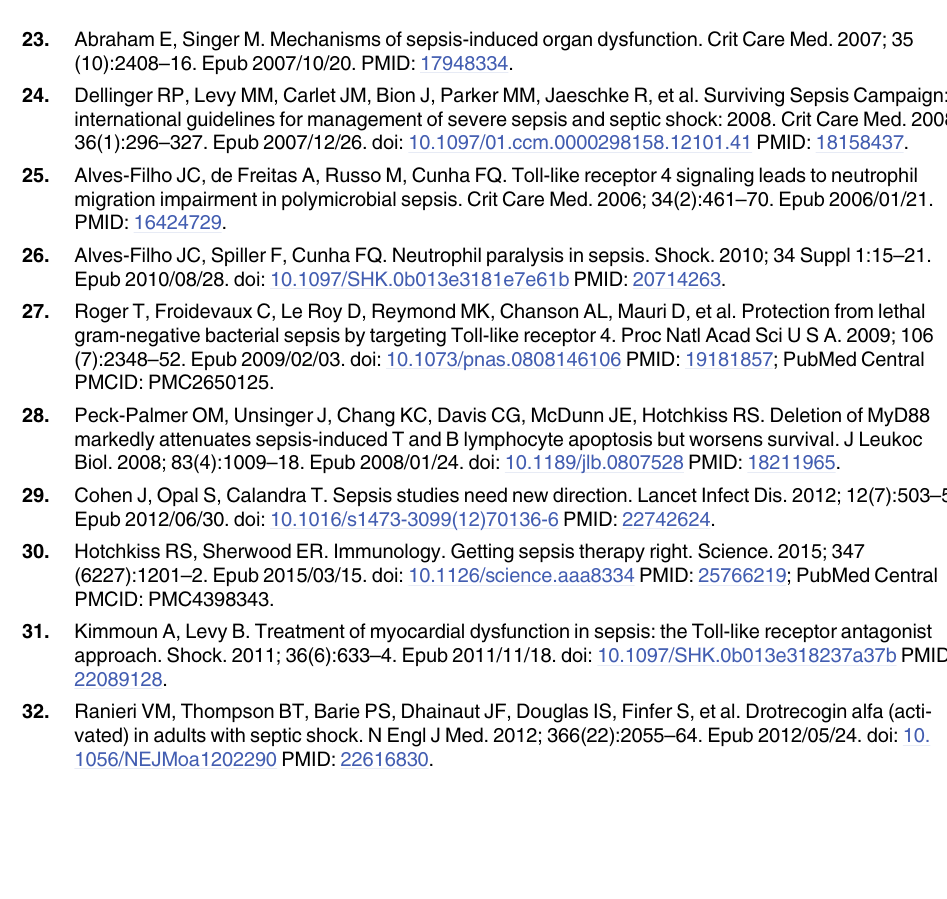
PLOS ONE | DOI:10.1371/journal.pone.0132336 July 6,